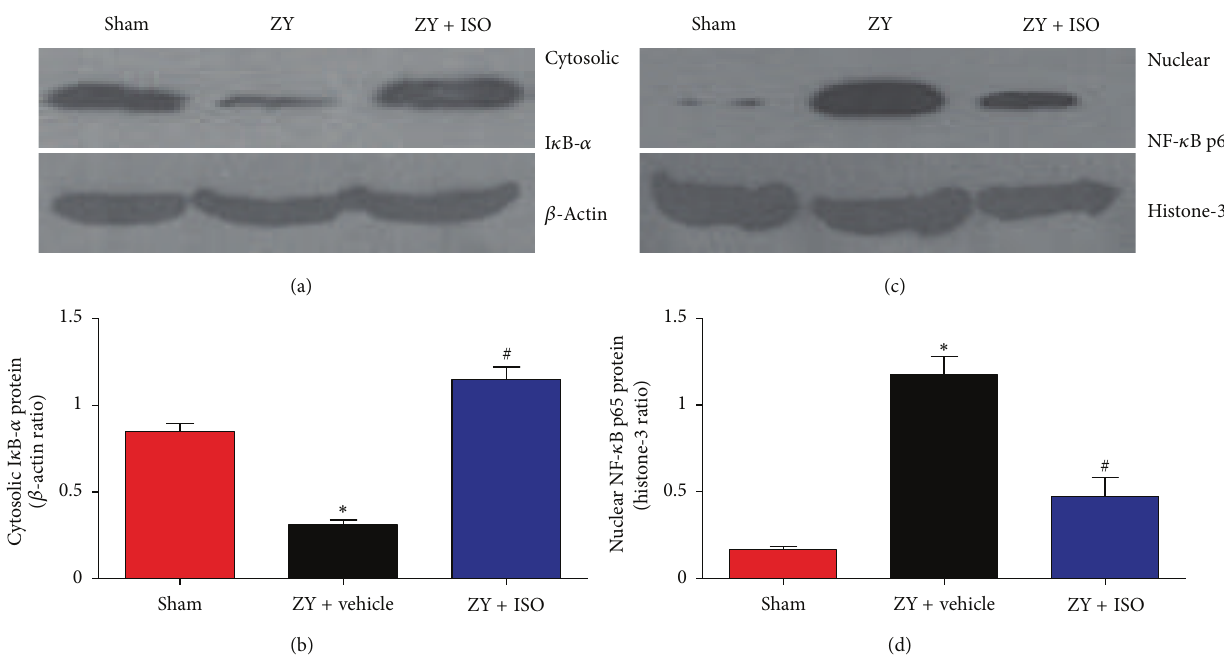
Figure 3: Treatment with 1.4% ISO reduces NF- 𝜅 B activation caused by ZY in the lung. (a) Western blot analysis of I 𝜅 B- 𝛼 expression in the cytoplasm, (b) protein bands densitometrically quantified and relative amounts of I 𝜅 B- 𝛼 protein normalized against 𝛽 -actin, (c) Western blot analysis of the nuclear levels of NF- 𝜅 B p65, and (d) protein bands densitometrically quantified and relative amounts of NF- 𝜅 B p65 protein normalized against histone-3. The respective densitometric analysis of protein bands is from three separate experiments. The animals were treated as described in Figure 1. Data are mean ± SD ( 𝑛 = 10 mice per group). ∗ 𝑃 < 0.05 versus sham; # 𝑃 < 0.05 versus ZY +